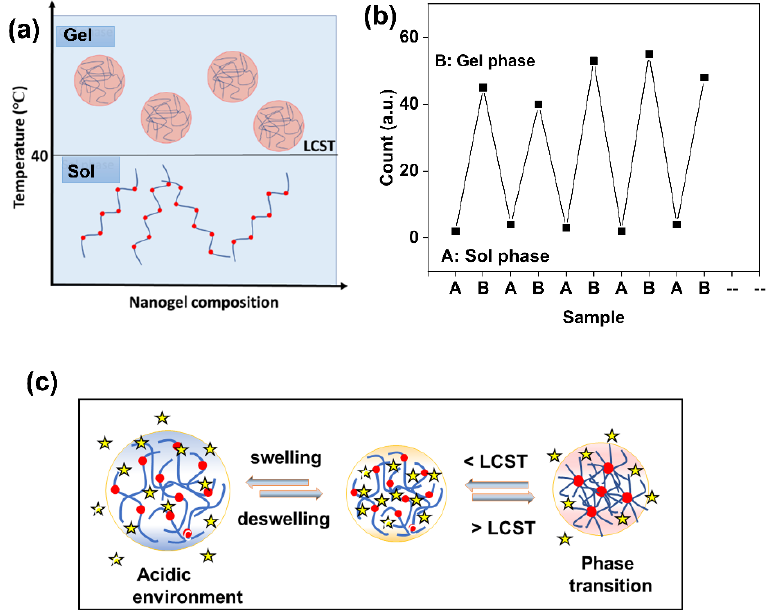
Figure 4. ( a ) A proposed schematic of the PNIPAm-co-PAAm HG conformational change in each phase state. Red color indicates the hydrophobic domain, and blue line indicates the hydrophilic polymer segments in the presence of water. ( b ) DLS analysis of PNIPAm-co-PAAm HG at below and above LCST. ( c ) Illustrates the phase transition of PNIPAm-co-PAAm HG under the pH stimulus. Red color indicates the hydrophobic domain, and blue line indicates the hydrophilic polymer segments in the presence of